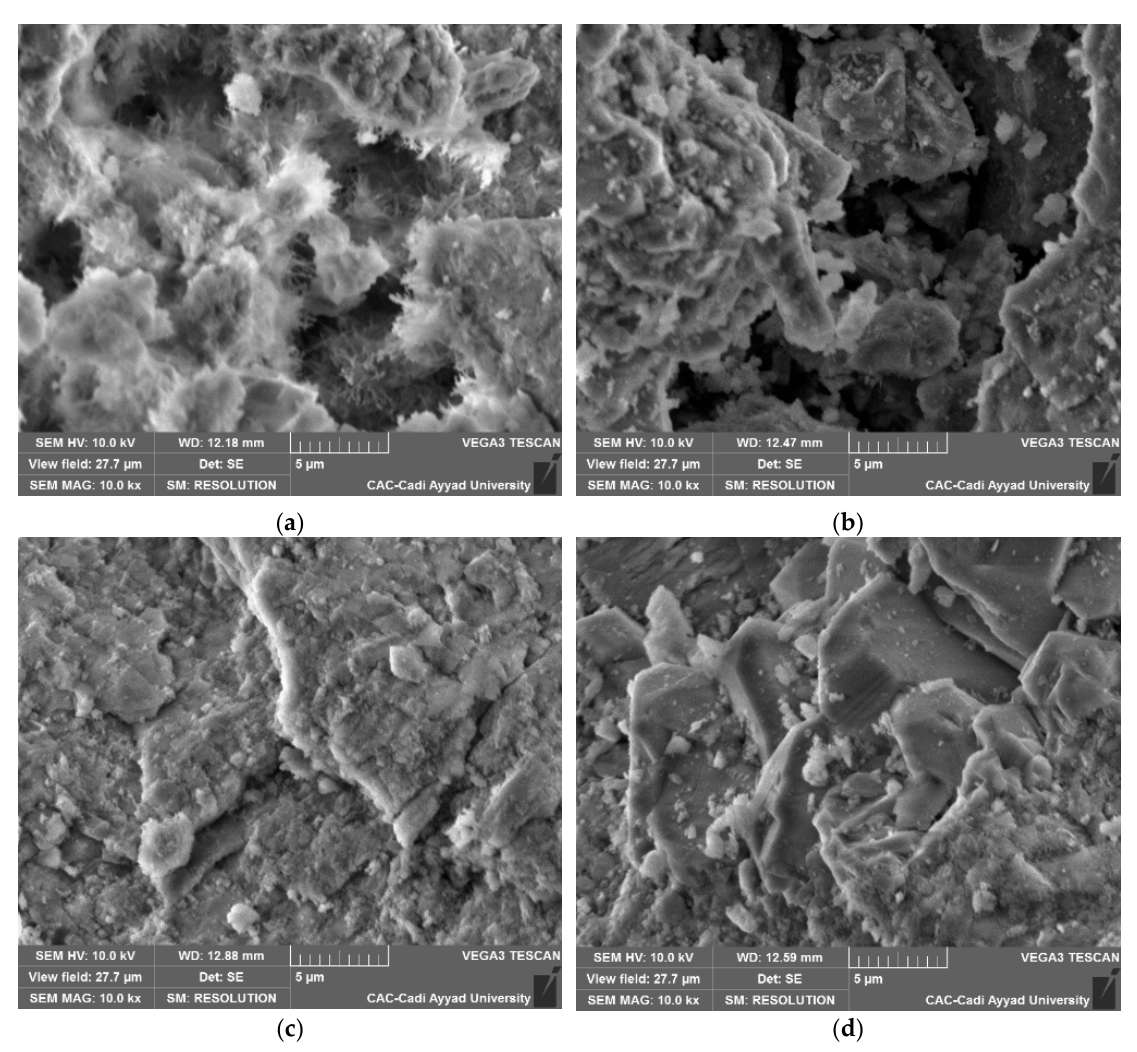
Figure 5. Variable Pressure Scanning Electron Microscopy of the SiO 2 aggregate without heat treatment ( a ) and heated at 500 °C ( b ), 700 °C ( c ), and 1000 °C ( d ).